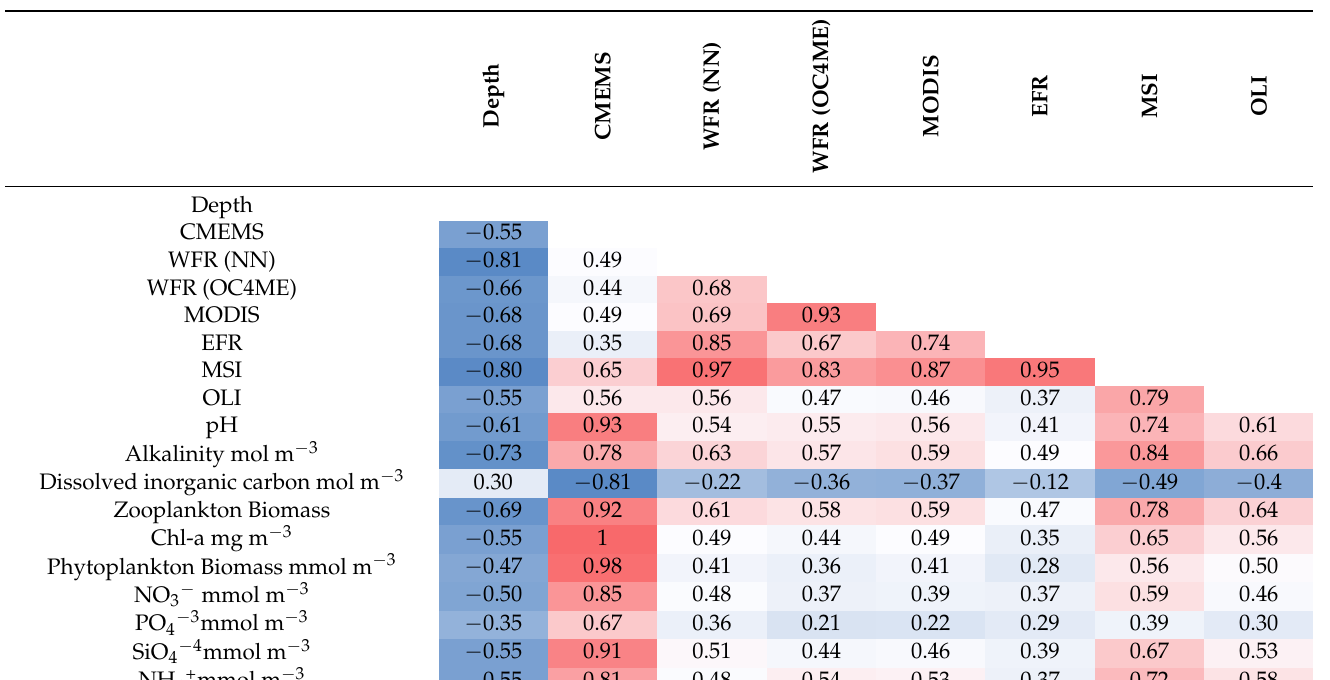
NB: Values are highlighted from largest (red) to smallest (blue). Significance level of p = 95% is adopted.